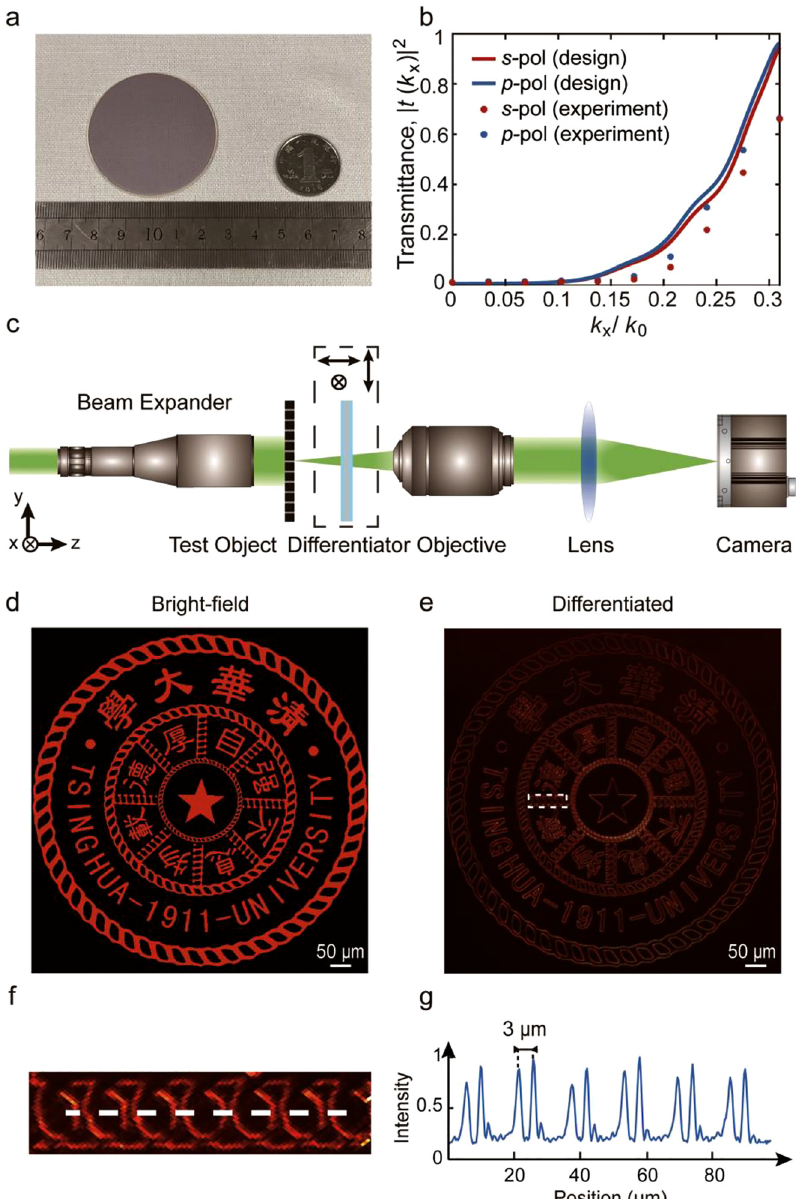
and a spatial resolution of about 2 μ m. With an improved fi lter response, Figure 3(e) shown the simulated image modulated by the optimized 17-layer SiO /Si thin fi lm. A 2 vertical cut of the modulated image, as shown in Figure 3(f), illustrates that the SiO /Si multilayer thin fi lm can also 2 reveal edges of the rectangle in all directions, but with much-reduced background noise and a spatial resolution of about 0.8 μ m. Experimentally, based on the SiO /TiO design, we 2 2 deposit the multilayer thin fi lm on a two-inch-diameter fused silica substrate using ion-assisted deposition avail- able from a commercial service (Beijing Qifenglanda Inc.),